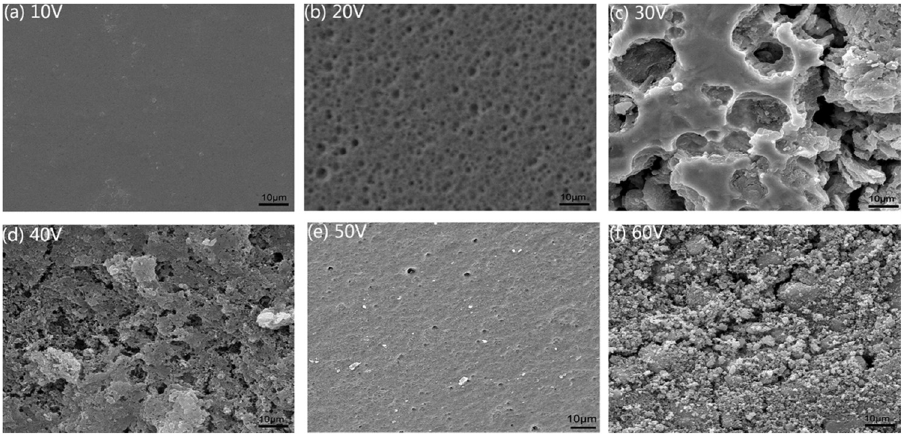
Figure 5: SEM images of spanner surface treated with di ff erent voltages for 40 min: ( a ) 10 V, ( b ) 20 V, ( c ) 30 V, ( d ) 40 V, ( e ) 50 V, and ( f ) 60 V.